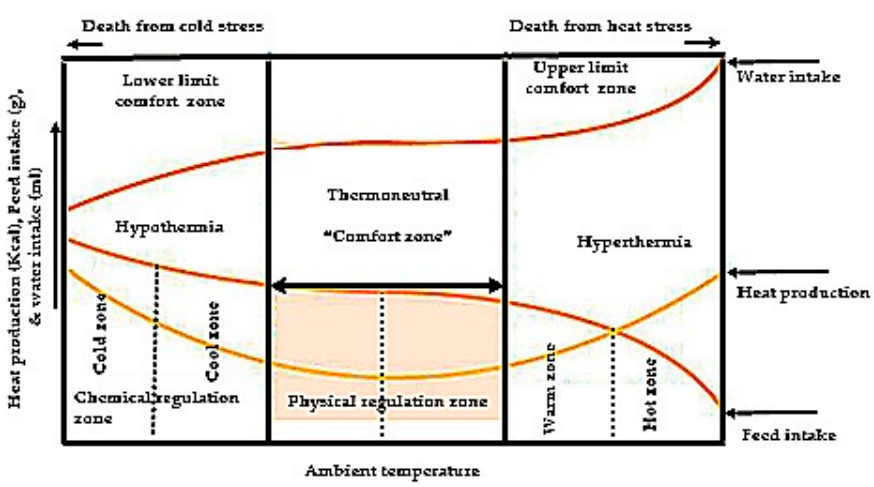
Figure 1. Feed and water intake, and body temperature production related to ambient temperature. Modified after [54].